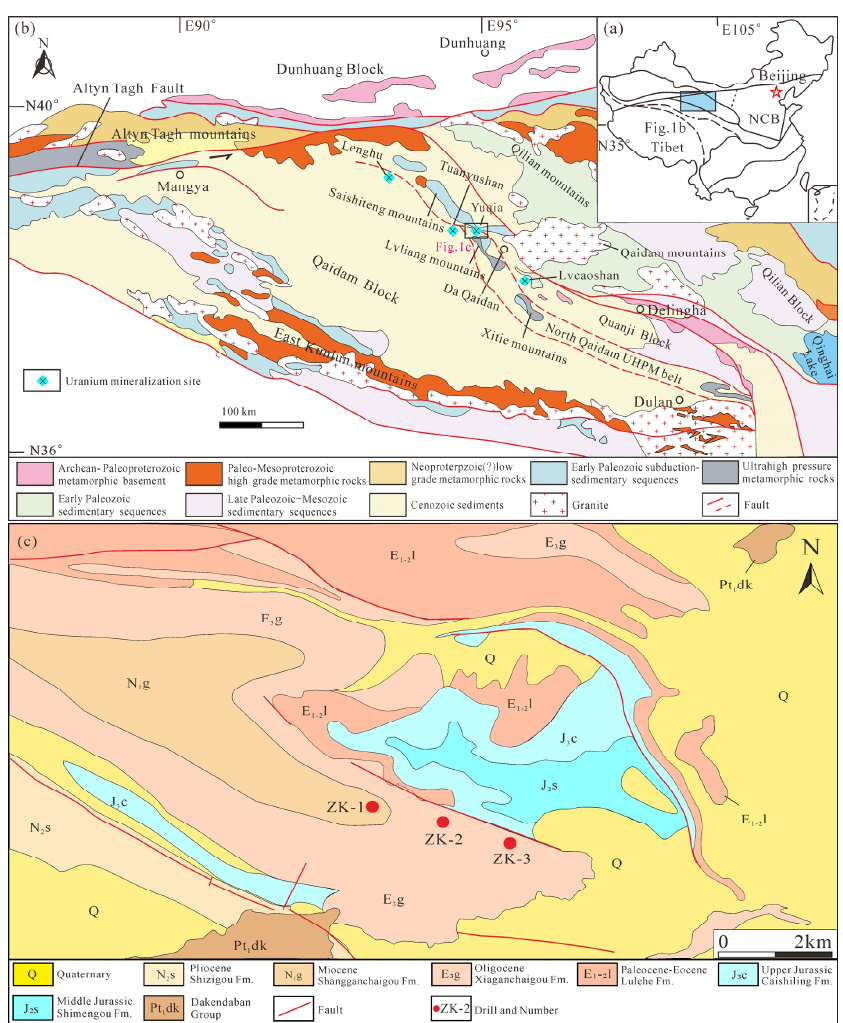
Figure 1. ( a ) A sketch map of the northern margin of the Qaidam Basin, China; ( b ) a geological map of the Qaidam Basin, showing well-developed structures, magmatic and metamorphic rocks, sedimentary units, and known uranium mineralization sites (modified after Yan et al. [20]); ( c ) a geological sketch of the Yuqia uranium deposits (modified after Lian et al. [21]).